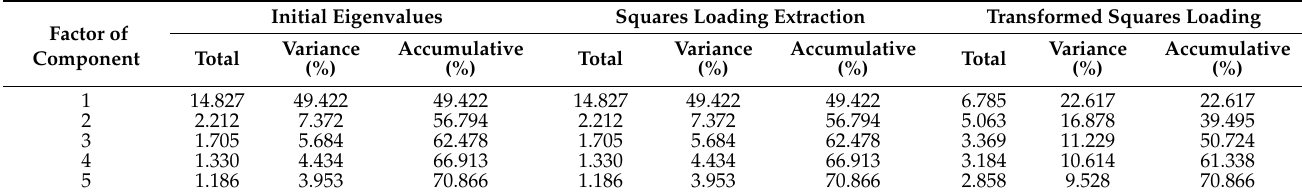
Table 7. Total variance explained.